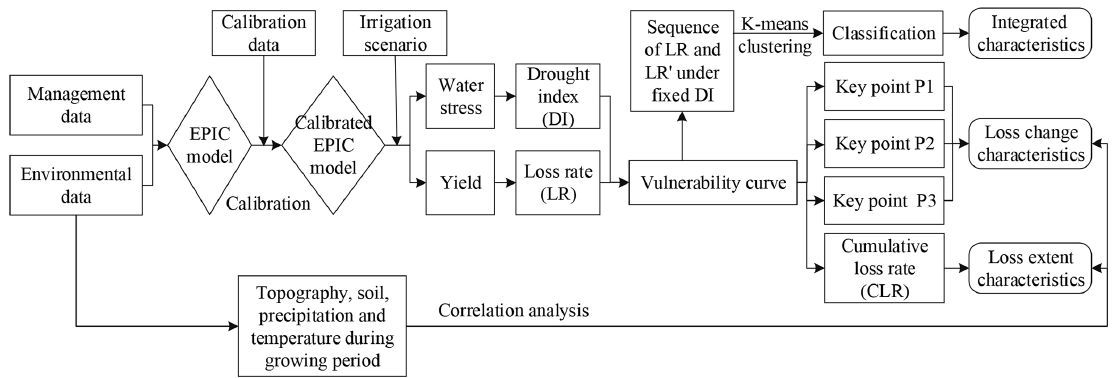
Figure 2. Basic research framework. First, we input relevant data into the EPIC model and perform model calibration. Next, we obtain a series of water stress and yield data based on the calibrated EPIC model by setting different irrigation scenarios, which are converted into drought index (DI) and yield loss rate (LR) for the construction of vulnerability curves. Then, we extract three key points and calculate the cumulative loss rate of vulnerability curves for the spatial analysis of loss change and loss extent characteristics. Finally, we calculate the LR and the growth rate of LR (LR (cid:48) ) under a set of fixed DI to transform the vulnerability curves into a finite data set for clustering, and the classification of vulnerability curves can be used for the integrated spatial